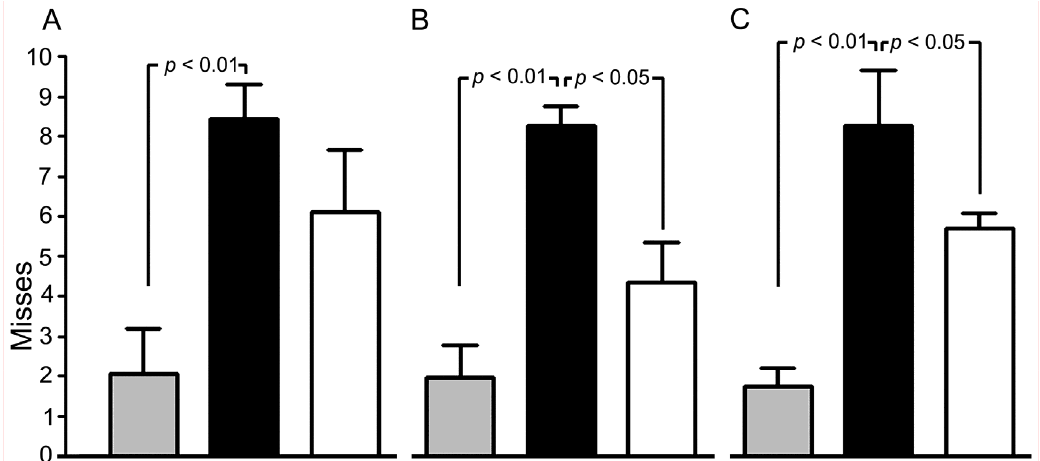
Figure 3. Effect of methylene blue (MB) on the neurological deficit in the right hindlimb caused by traumatic brain injury (TBI). Beam-walking test, the 7th day after TBI ( A ), the 30th day after TBI ( B ), the 180th day after TBI ( C ). Administration of methylene blue 30 min after the injury and then monthly (6 injections in total). Animals treated with saline solution after the trauma (black columns); animals treated with MB after the trauma (white columns), sham-operated animals (grey columns).